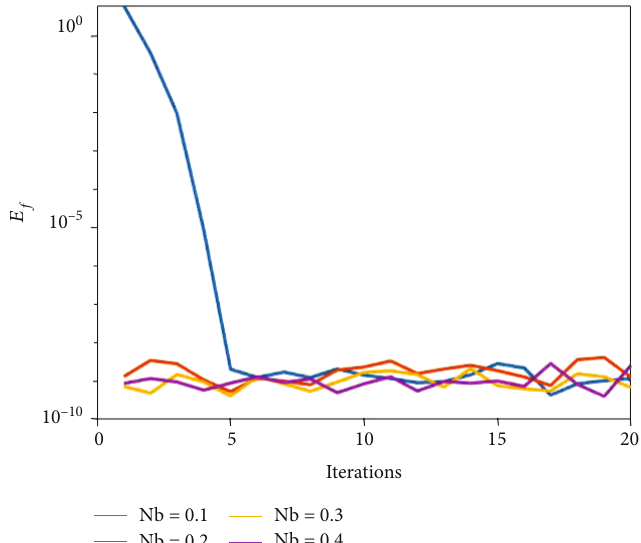
: 8, ξ = 1, N N Df = Bi = Sr = 0 : 5, He b = t = w = 0